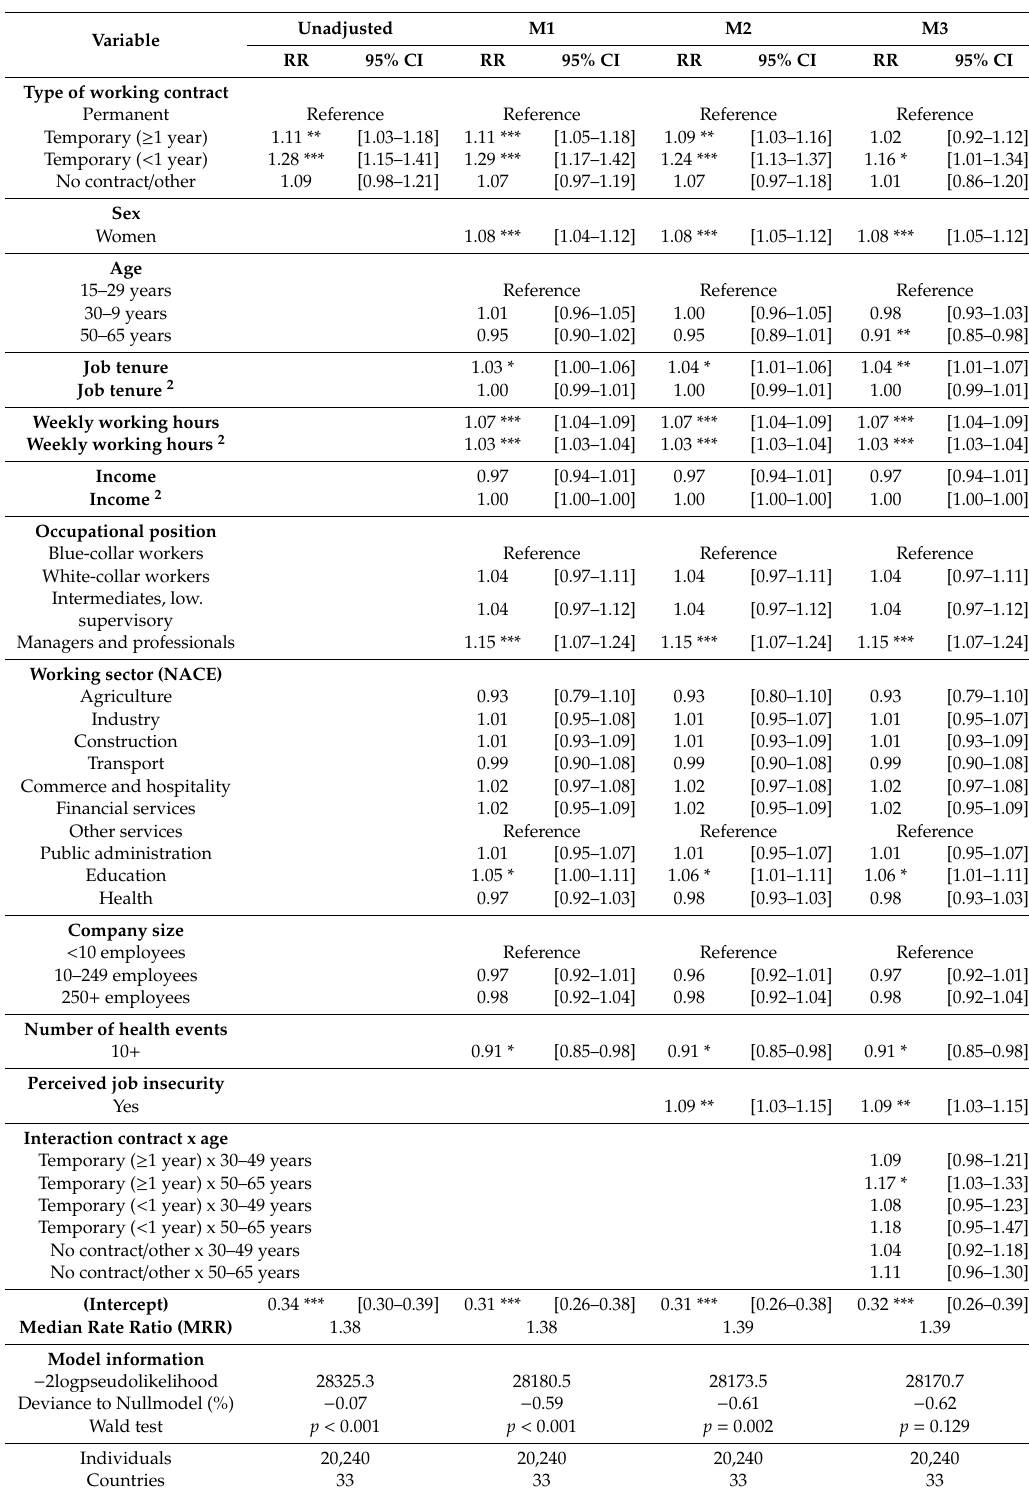
Table A2. Multilevel Poisson regression: Rate ratios (RR) of presenteeism propensity by di ff erent sets of covariates (Complete version of Table